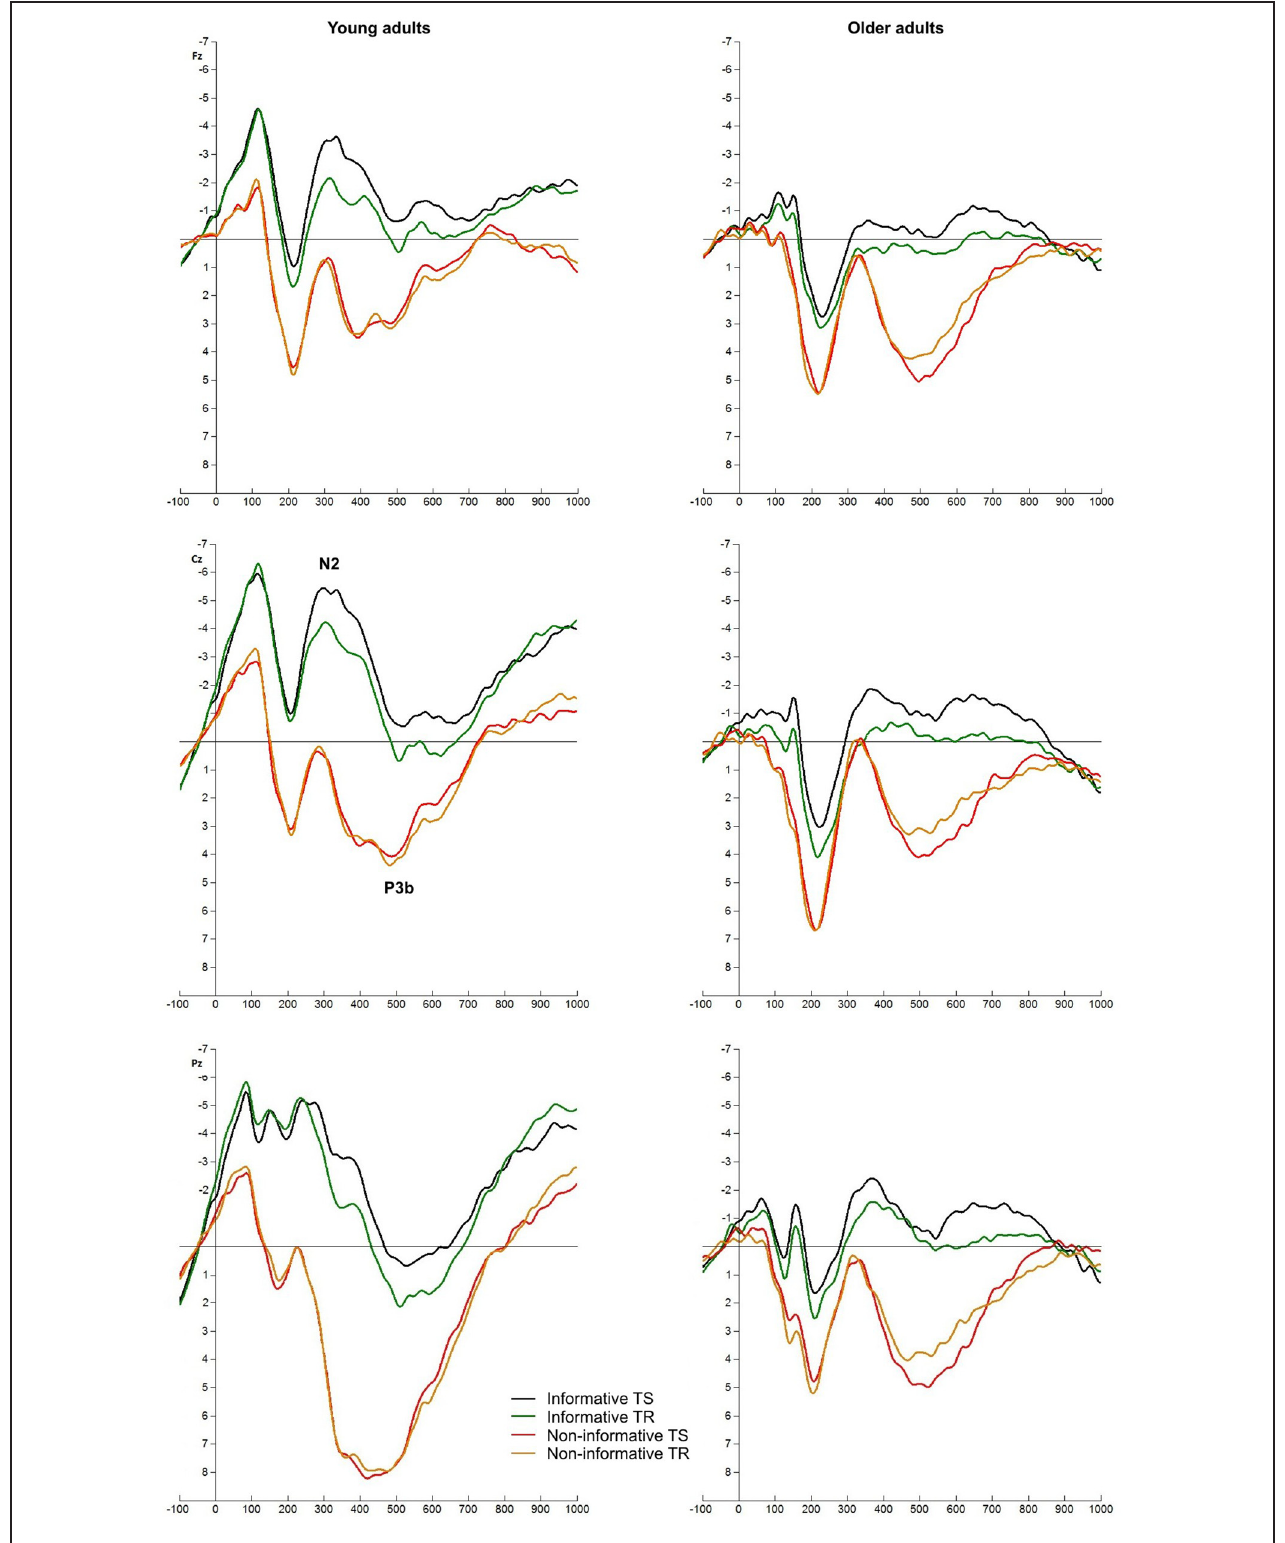
FIGURE 5 | Target-locked ERPs at Fz, Cz, and Pz electrodes in informatively (TS – black, TR – green) and non-informatively cued (TS – red, TR – orange) conditions in young and older groups.